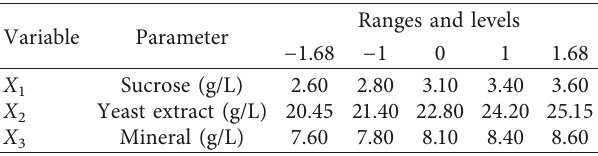
Table 4: Experimental ranges and levels of the independent